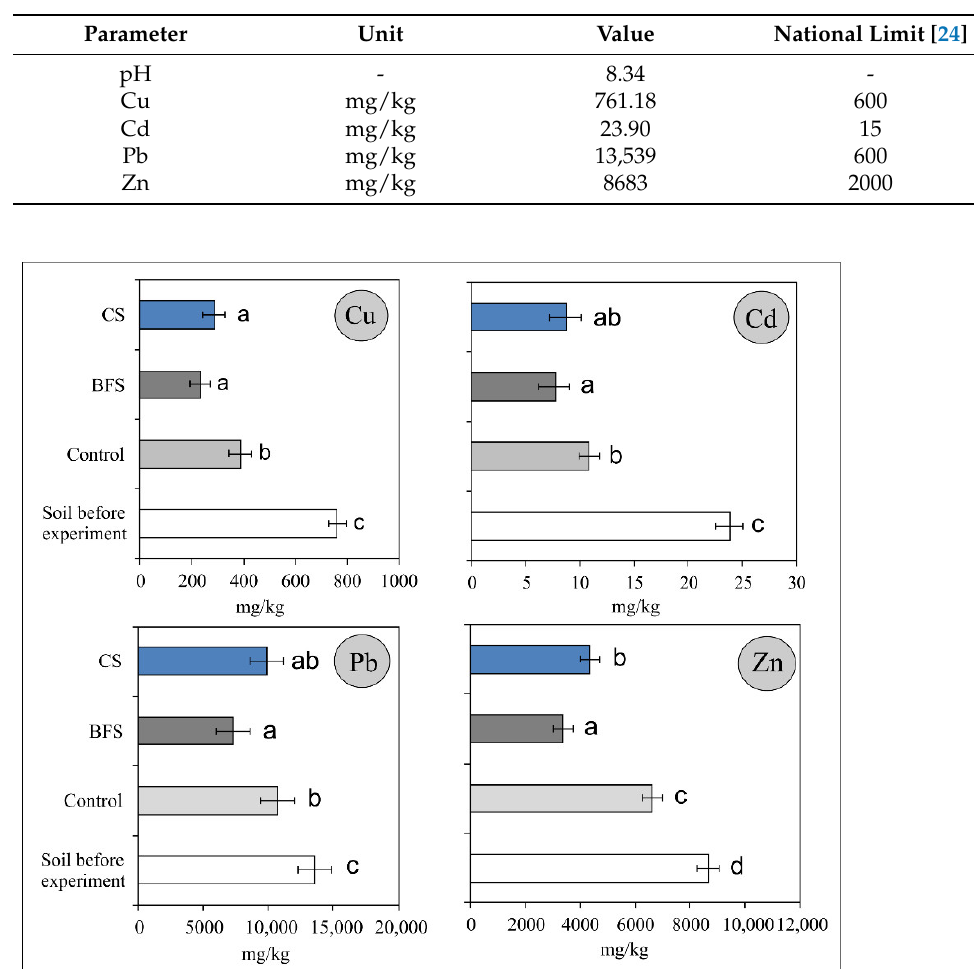
Table 2. Selected physicochemical characteristics of the experimental soil.